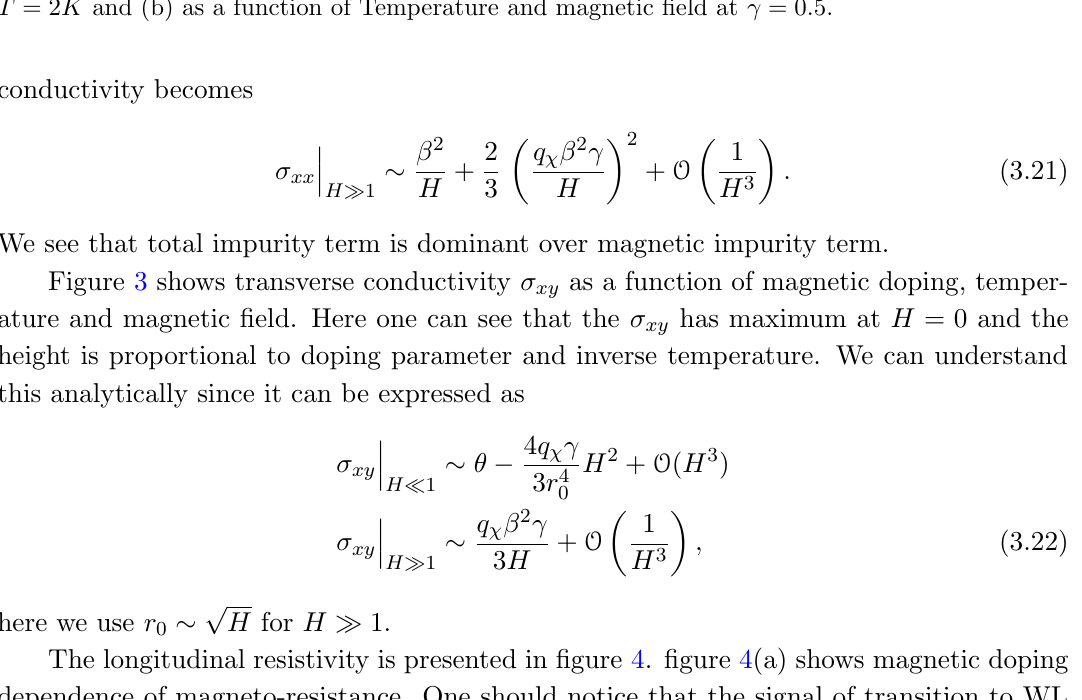
Figure 4 . longitudinal resistivity (cid:26) xx , (a) as a function of Magnetic doping and magnetic (cid:12)eld at T = 2 K and (b) as a function of Temperature and magnetic (cid:12)eld at (cid:13) = 0 :